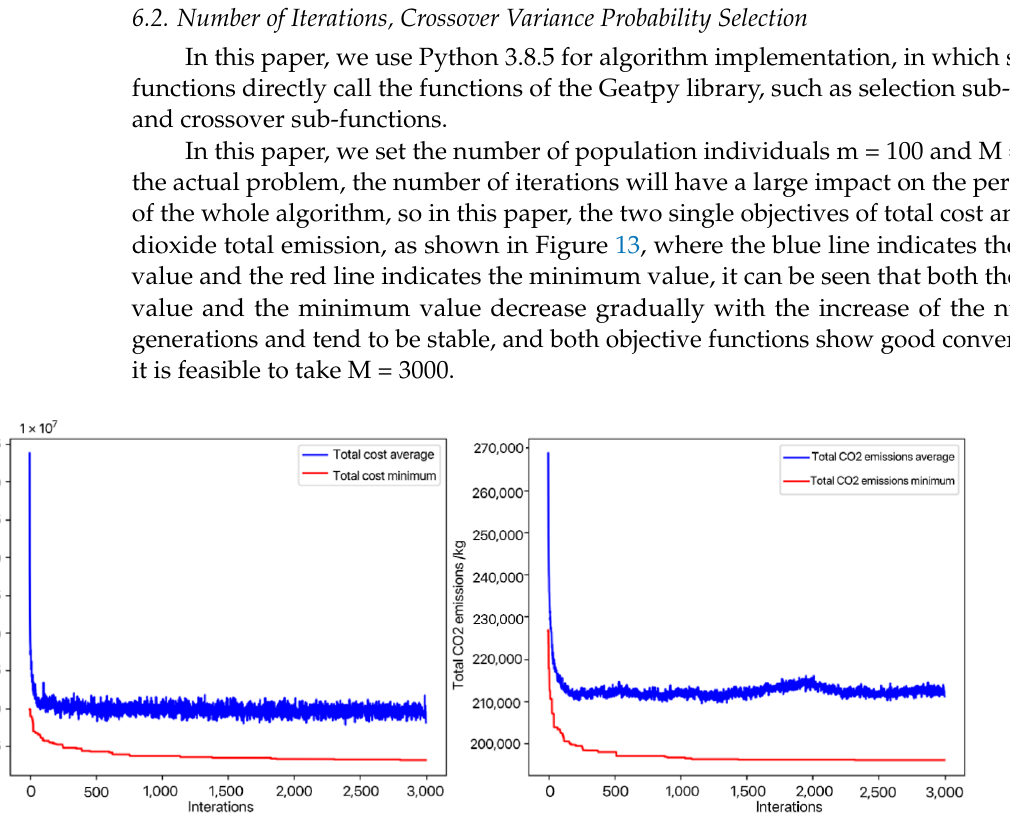
Table 9. Correlation indicators.